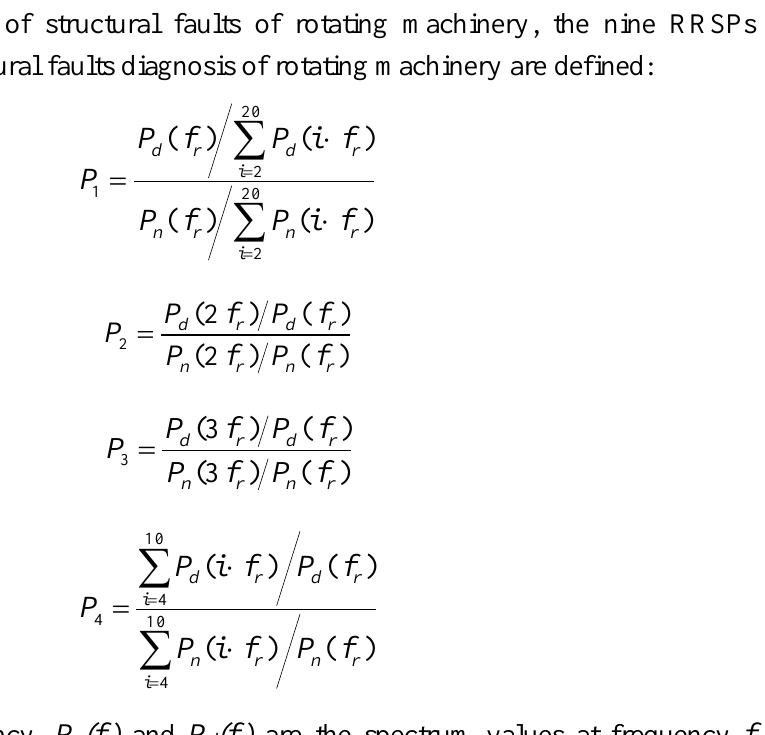
Diagnose using the leaned